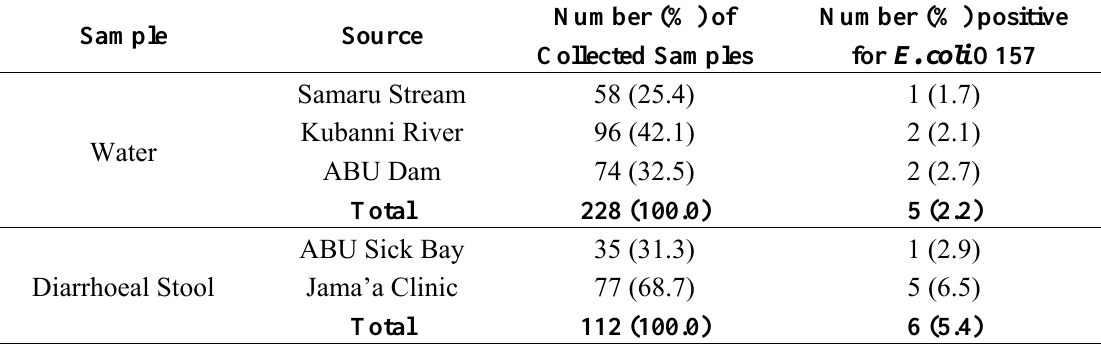
Table 1. Prevalence of Escherichia coli O157 in Surface waters and among Diarrhoeal Patients in Zaria,